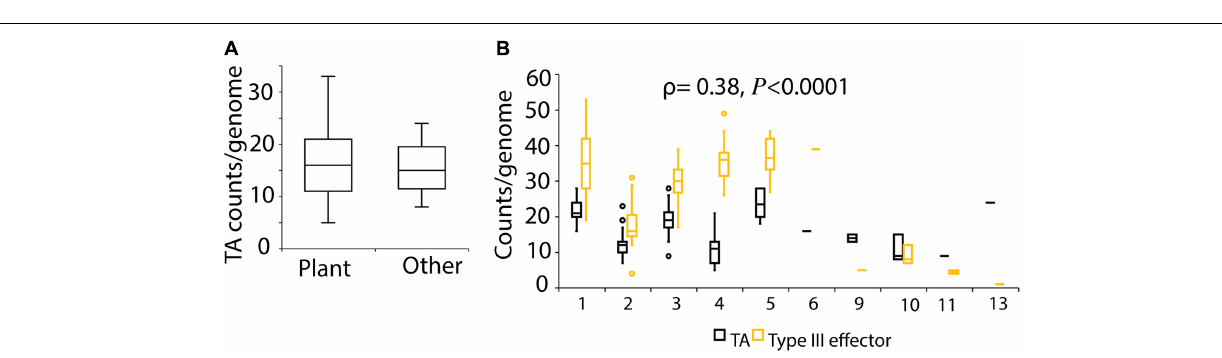
FIGURE 4 | (A) TA counts by isolation source of strains. Strains isolated outside of plant environment (rain, snow, stream, lake water, epilithon) were categorized as other ( n = 13). (B) TA counts and type III effector counts by phylogroups (x-axis). Type III secretion system effector counts predicted in 140 genomes from a previous study (Dillon et al., 2019b) were used. Strains of phylogroup 7 were not used in this analysis as the strains used here were not used in Dillon et al.